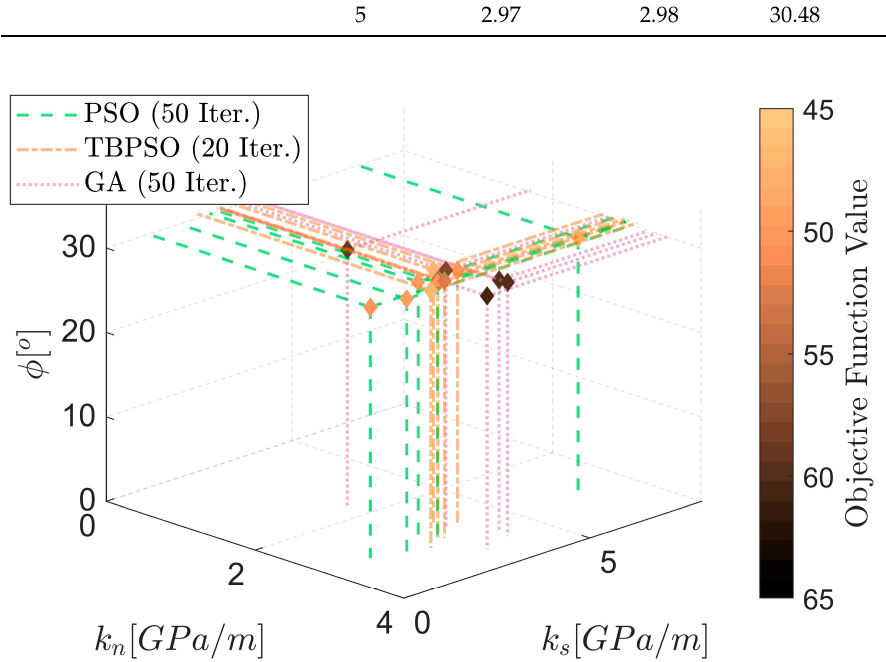
Figure 22. Failure mode of densely meshed geometry for best set of material parameters using ob- jective function 1; the colour legend represents the displacements in metres.